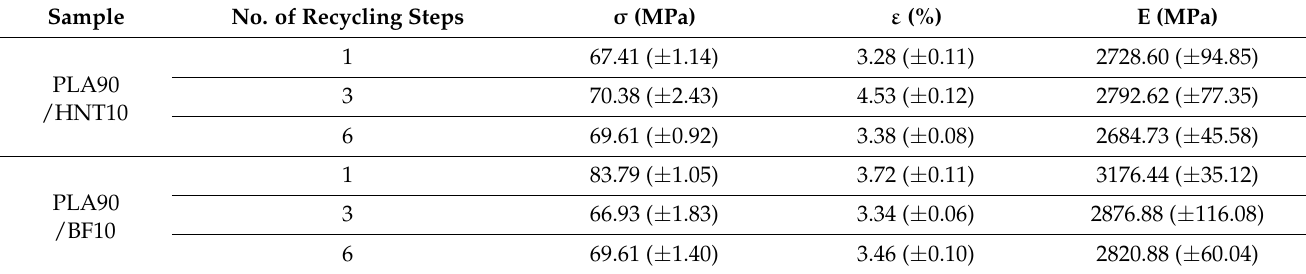
Table 4. Tensile properties of tested samples ( n = 6). ( σ ) tensile stress at break, ( ε ) tensile strain at break and (E) Young’s Modulus.